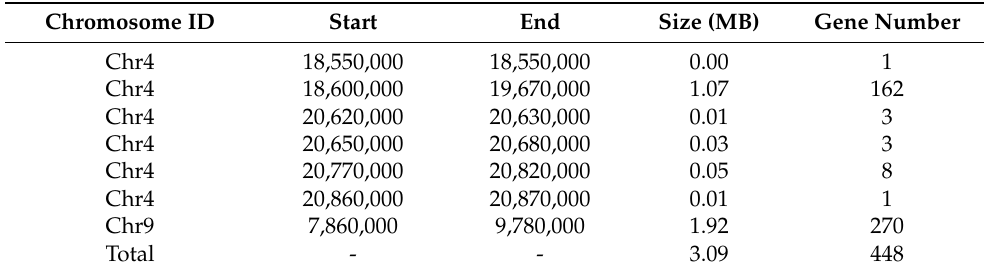
Table 2. Candidate regions of seed storability of DXWR.